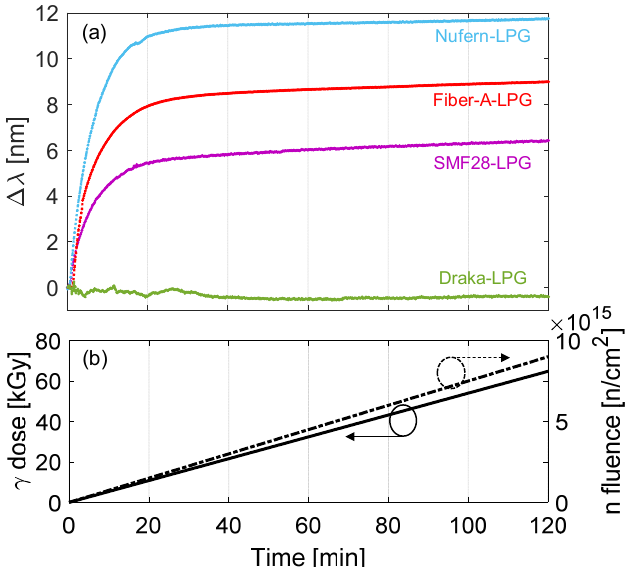
Figure 5. Mixed neutron-gamma irradiation of arc-induced LPGs: ( a ) resonance wavelength shift; ( b ) irradiation profiles. © 2017 Springer Nature. Reprinted from [84] (CC BY 4.0).